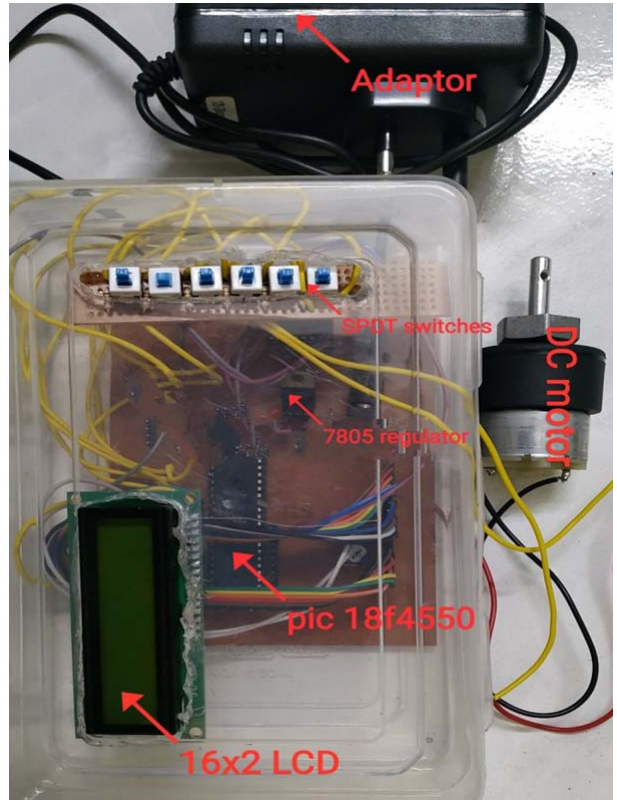
Figure 6. Hardware implementation.